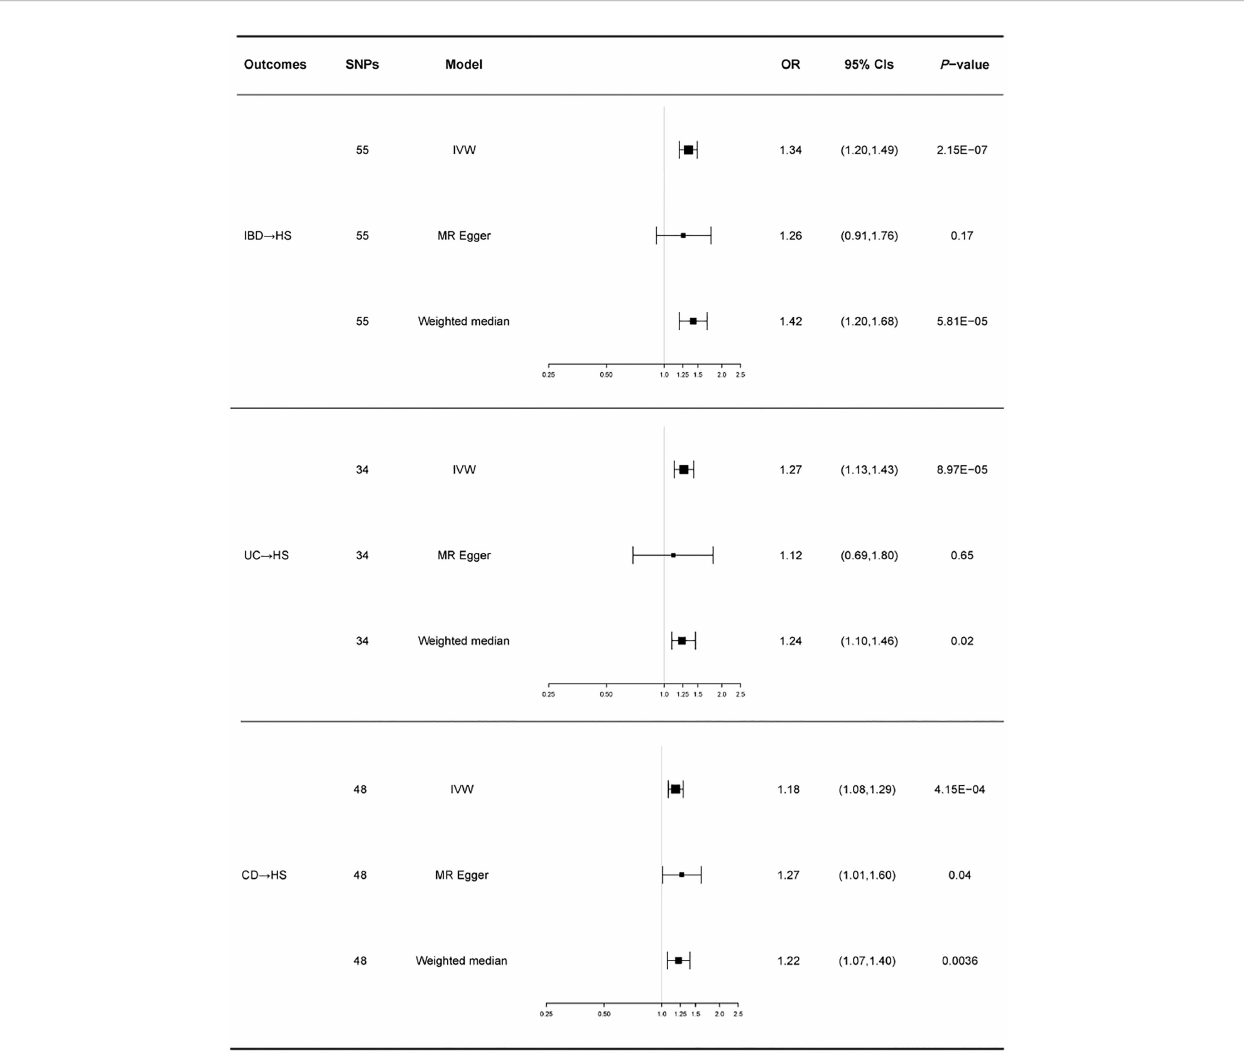
FIGURE 3 For the effects of in fl ammatory bowel disease, ulcerative colitis, and Crohn ’ s disease on hidradenitis suppurativa, causal estimates are given as odds ratio (OR) and 95% con fi dence interval (CI). IBD, in fl ammatory bowel disease; UC, ulcerative colitis; CD, Crohn ’ s disease; HS, hidradenitis suppurativa.